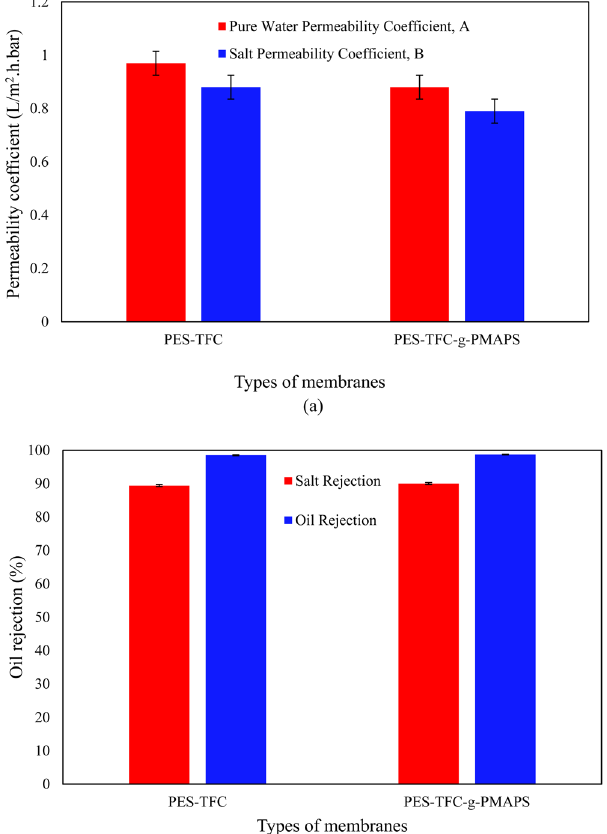
Figure 4. Transport properties of the single-skinned and double-skinned TFC membranes, ( a ) pure water permeability coefficient and salt permeability coefficient and ( b ) salt rejection (Red) and oil rejection (Blue) for DI water and 10,000 ppm oil water solution tested under RO mode at 9